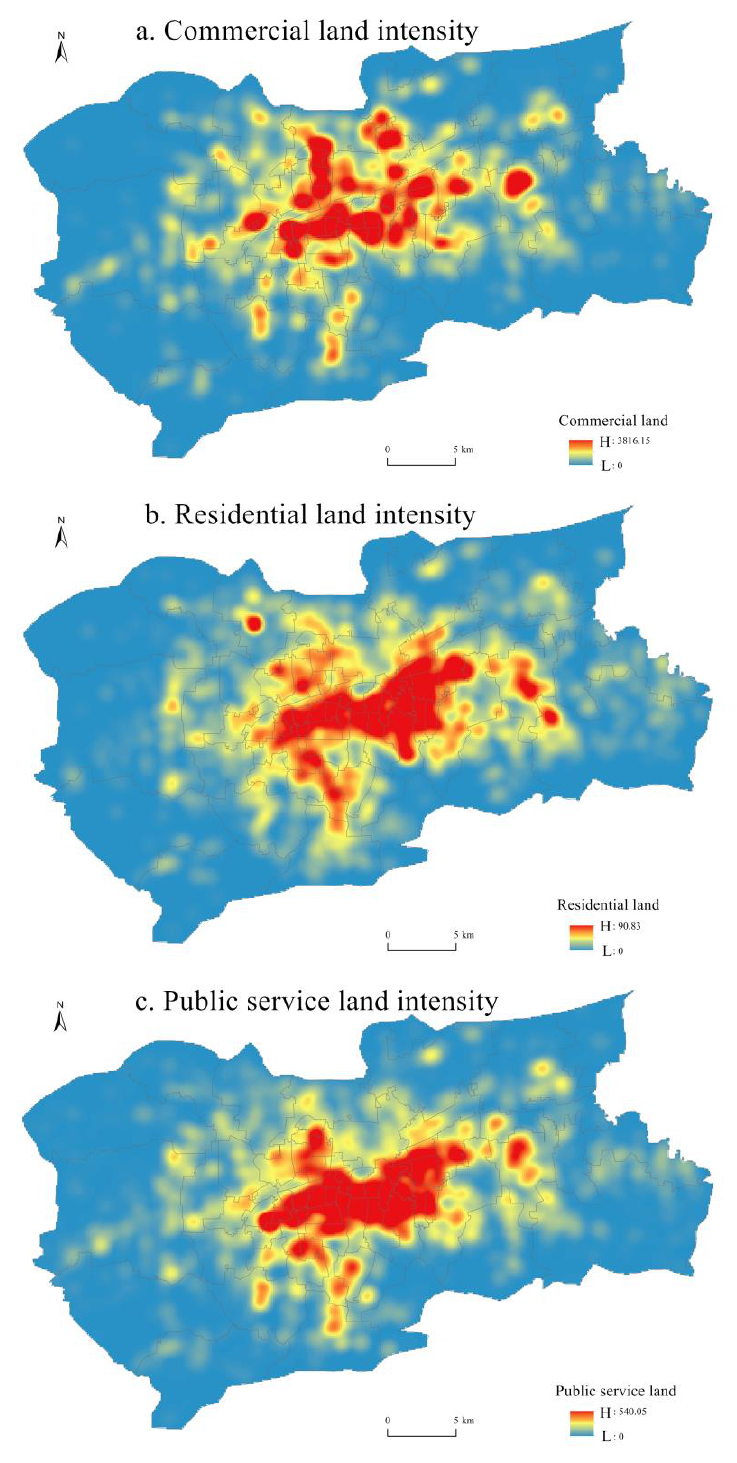
Figure 4. Spatial distribution of LUI.